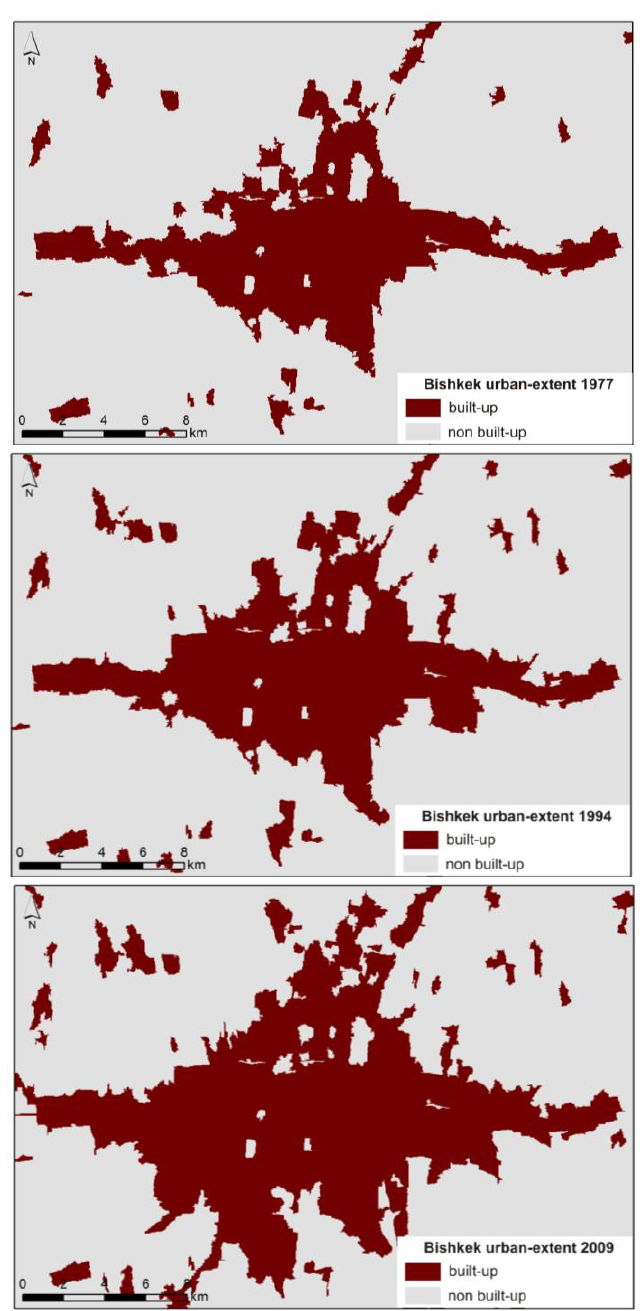
Figure 3. Urban-extent of Bishkek in 1977, 1994 and 2009. The binary maps have been extracted from Landsat TM and MSS images using supervised object-based image